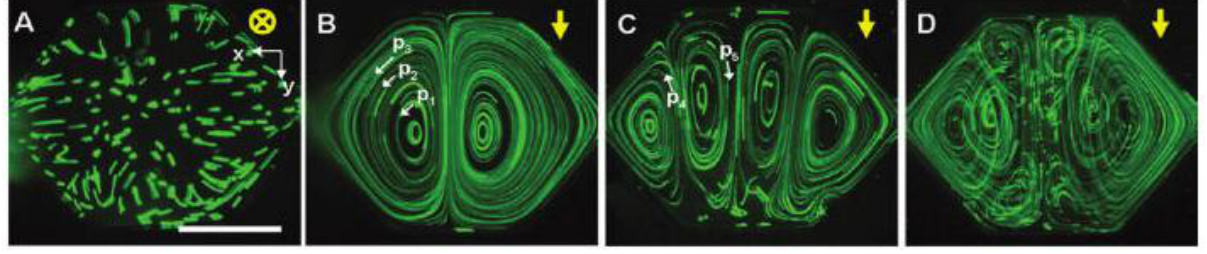
Figure 24. Natural convection-driven flows in a chamber. ( a – d ) Flow trajectories of fluorescent microparticles taken for 35 s. Measured maximum temperatures, Tmax, in (a) to (d) are 52, 51, 46, and 50 °C, respectively. The yellow arrows indicate the gravity direction, and the white arrows depict the flow direction of the individual fluorescent particles of 8 µm diameter. Scale bar, 1 mm. Reprinted with permission from [33]. Copyright 2009 American Chemical